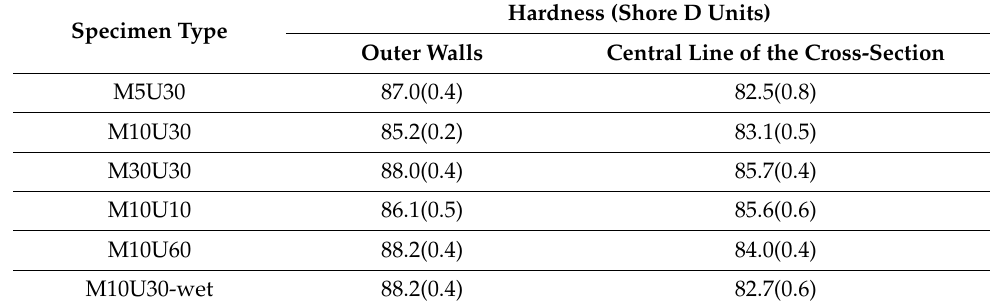
Table 4. Summary of hardness test (Shore method, type D) results for the produced printouts.